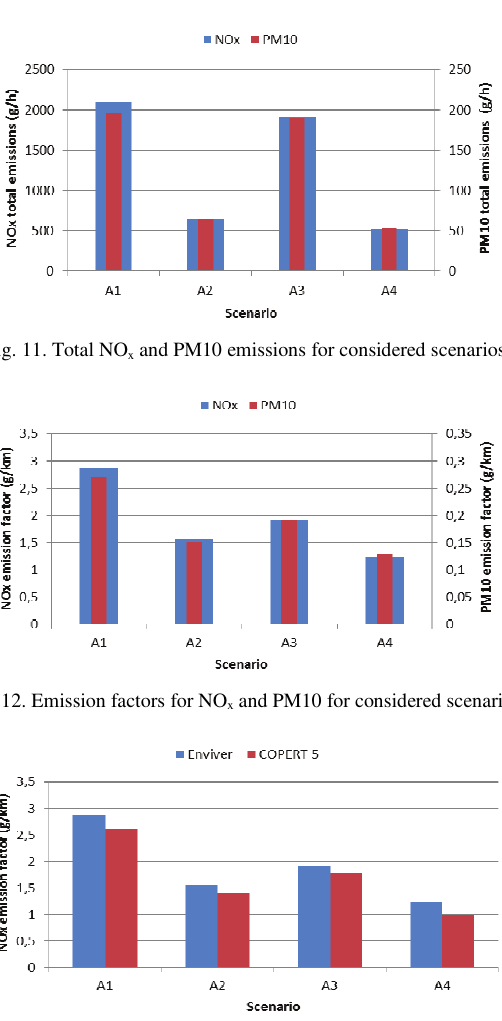
Fig. 10. PM10 emission results for considered scenarios with spatial resolution of 5x5 m